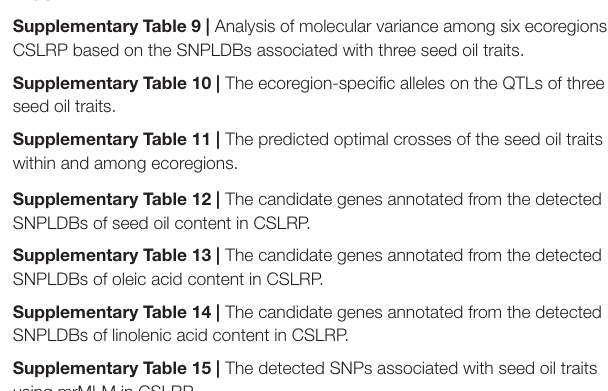
Supplementary Table 5 | Distribution of detected QTL of three seed oil traits in CSLRP.